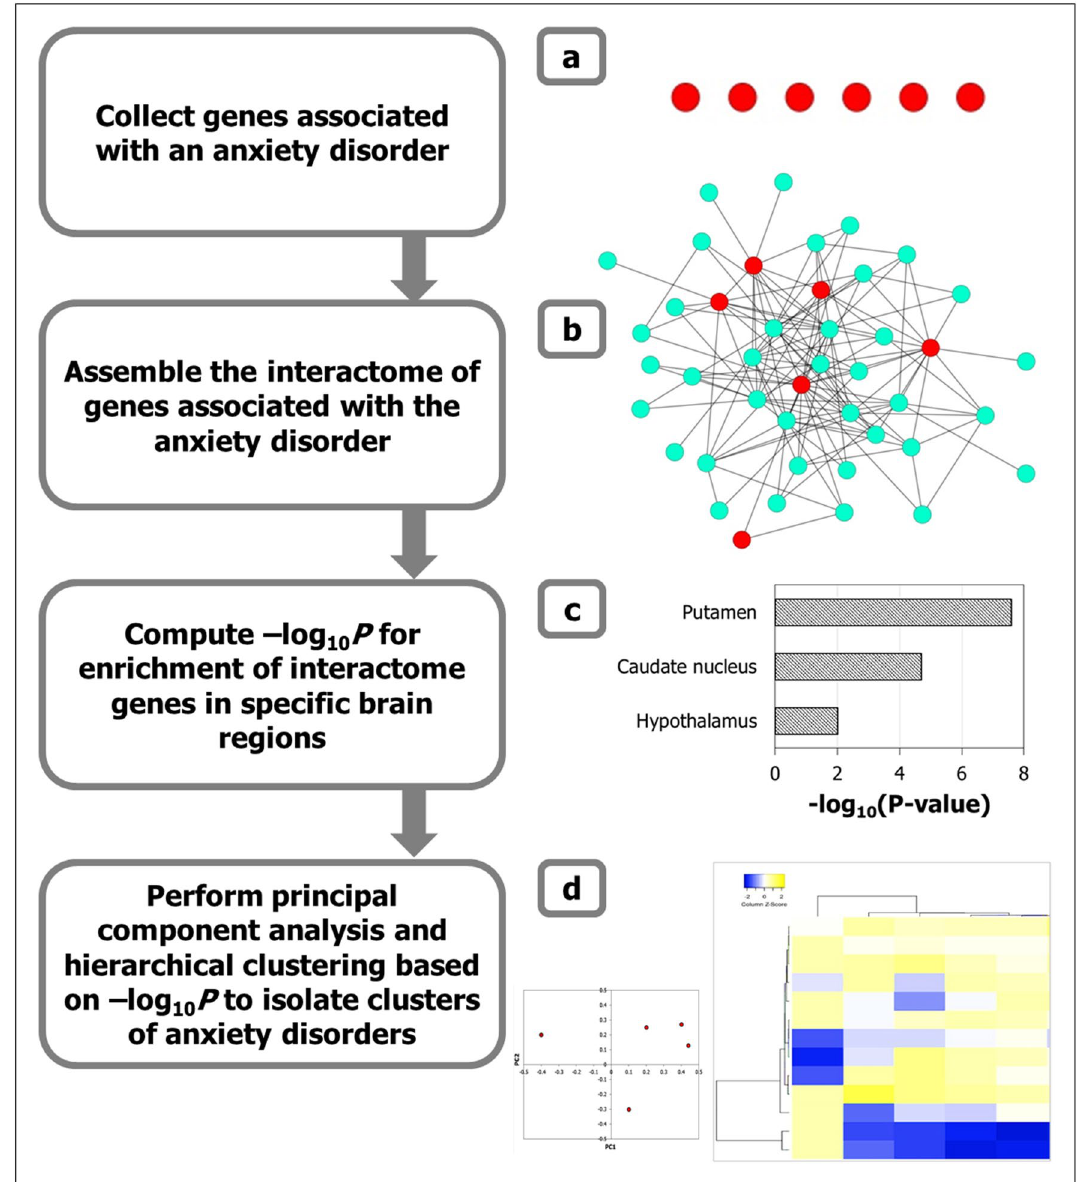
Figure 1. Methodology to identify regional specificity of ADs in the brain. ( a ) Genes associated with six types of ADs were compiled (depicted as red nodes), and ( b ) their protein interactomes assembled by curating the interactions of the proteins encoded by them with other proteins (i.e. interactors depicted as cyan colored nodes in the network diagram). These protein–protein interactions or PPIs are depicted as edges in the network. ( c ) The enrichment of the individual ADIs with genes showing medium/high expression (TPM ≥ 9) in specific brain regions were computed, and the statistical significance of these enrichments were calculated as negative logarithm of p values (i.e. –log 10 P). TPM = transcripts per million. ( d ) Principal component analysis (PCA) was performed to identify specific grouping patterns from the data matrix of –log 10 P of enrichment of each ADI in specific brain regions. Principal components which explain a large percentage of the variance observed across this data matrix were identified, and the component loadings denoting the correlation of the original variables (− log 10 P of specific brain regions) with the principal components were examined to interpret the observed patterns. The data matrix was also subjected to hierarchical clustering to delineate closely related groups of ADs. In the heat map, regions were colored according to the z-scores indicating their mean enrichment in the ADI. The z-scores indicate the number of standard deviations that separate a given p value from the mean. High z-scores correspond to high enrichment for the specific